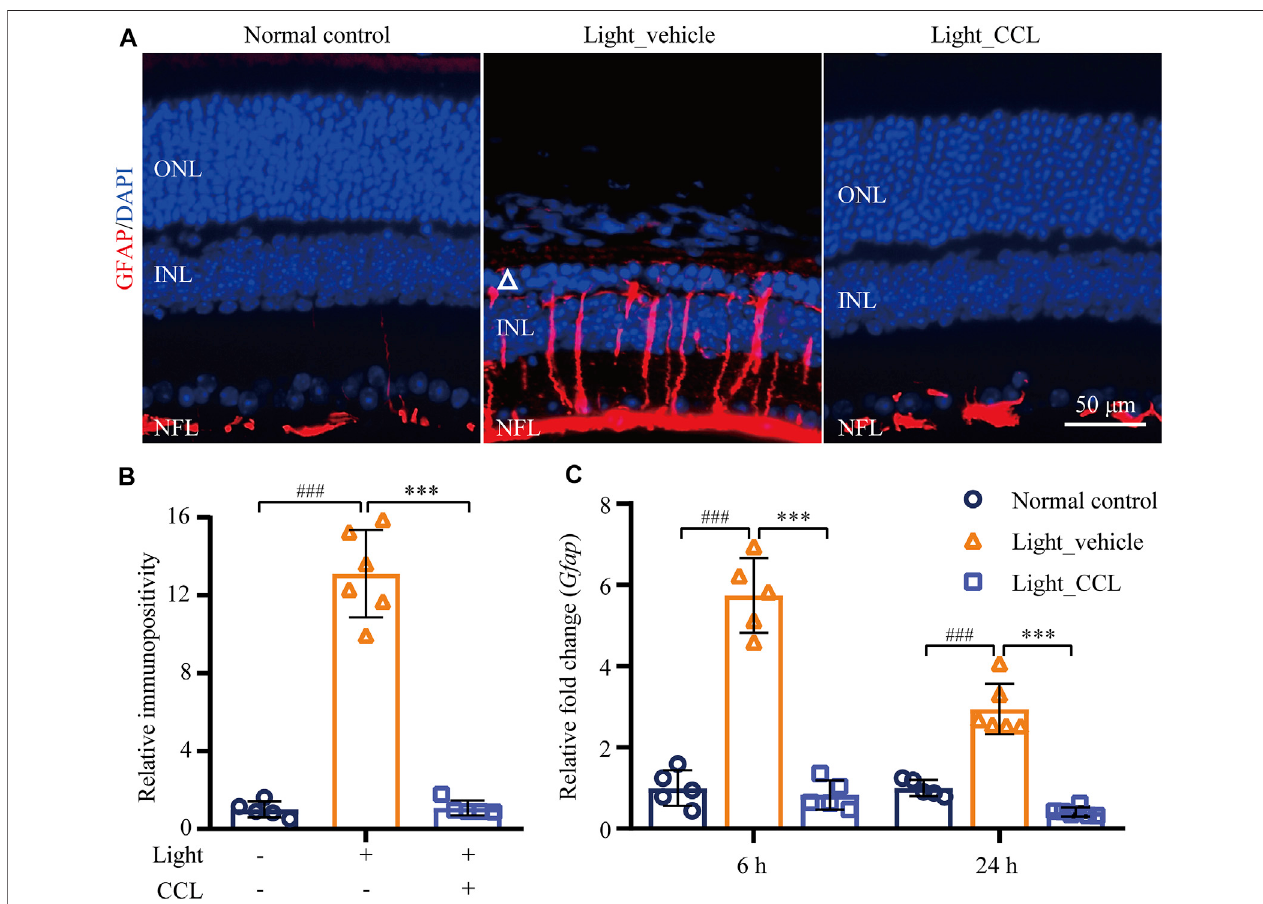
FIGURE 8 | CCL attenuates reactive müller gliosis in the light-exposed retinas. IHC was performed to examine the expression of GFAP in the retina (in red). Counterstaining of DAPI (in blue) was performed. The immunopositivity of GFAP in the retina was quanti fi ed by ImageJ. (A) Representative micrographs showing the expression of GFAP in the retina. (B) The relative immunopositivity of GFAP in the indicated experimental groups was plotted against that from Normal control. (C) Total RNAwasisolatedfromtheretinascollectedfromtheindicatedexperimentalgroups6and24 hafterlightexposure.Real-timeqPCRwasthenperformedtoanalyze the retinal expression of GFAP. 18S rRNA was ampli fi ed as an internal control. The relative fold change in the expression of GFAP was plotted against that from Normal control.INL,innernuclearlayer;NFL,nerve fi berlayer;ONL,outernuclearlayer.Scalebar,50 μ m.Datawereexpressedasmean±SD(n=5-6pergroup). ### Compared to Normal control, p < 0.001; *** compared to Light_vehicle, p <